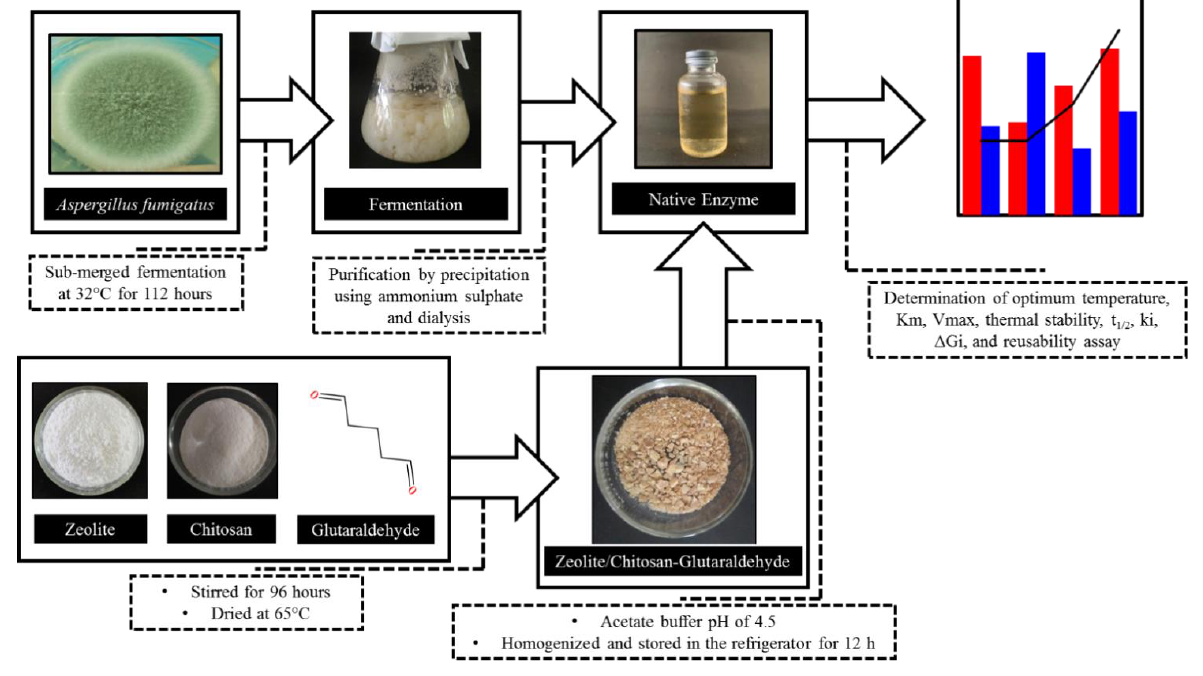
Figure 1. Flowchart of the research